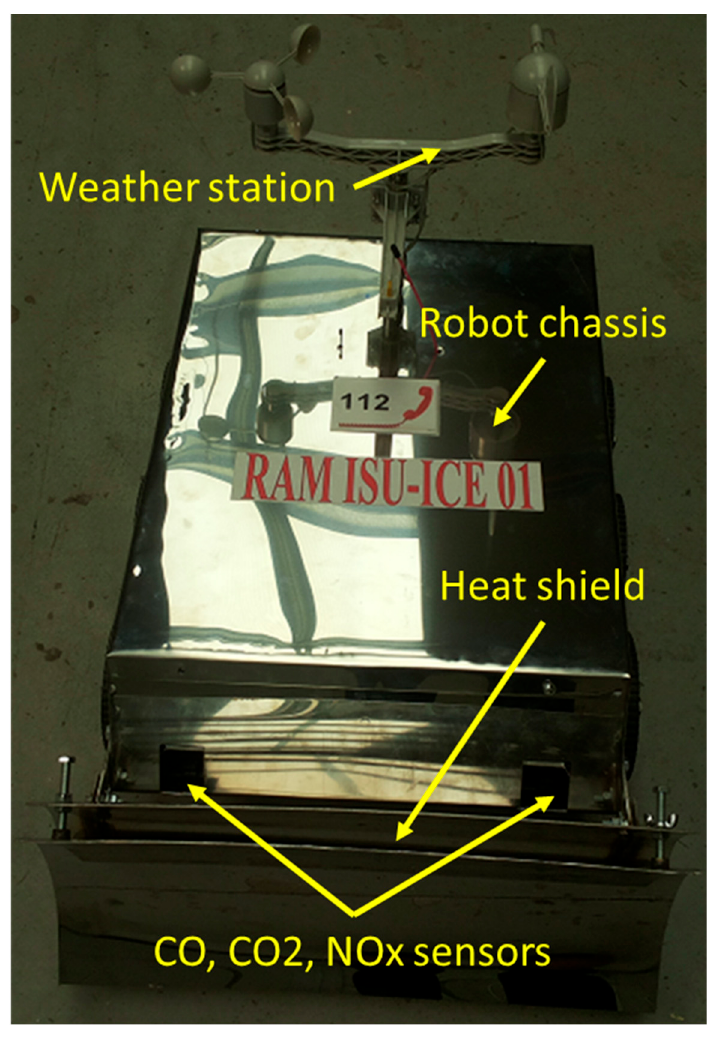
Figure 2. Robotic fire extinguisher with thermal protection shield.